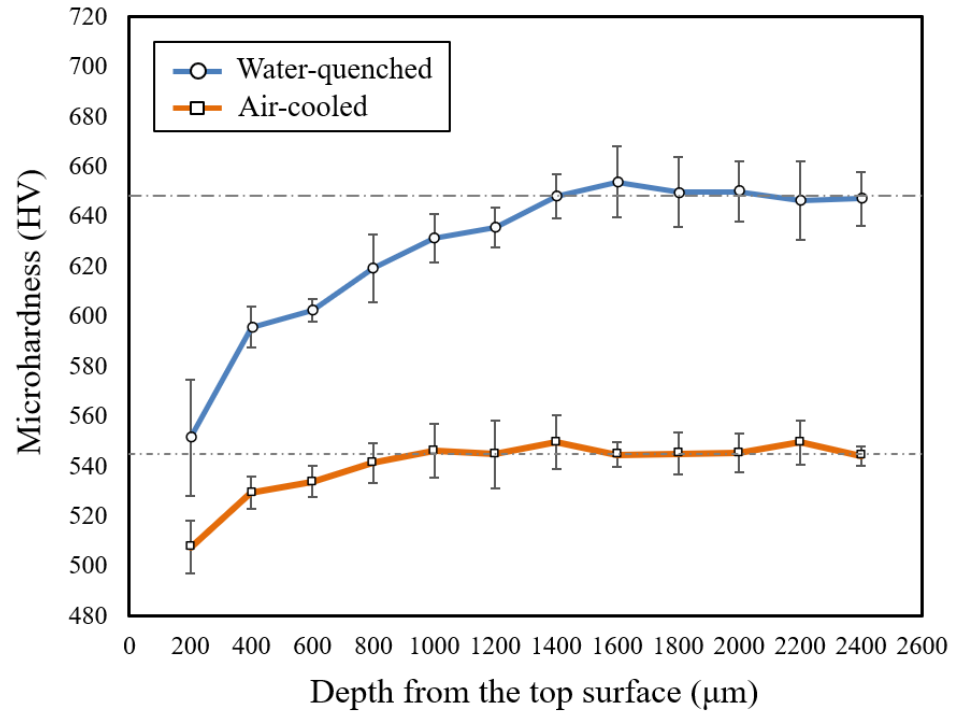
Figure 10. Vickers microhardness profile of the furnace-heated sample (water-quenched and air- cooled) showing a decrease in surface microhardness from the top surface.